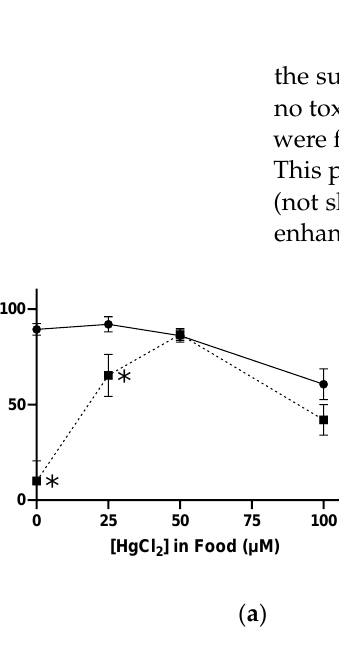
Figure 9. Eclosion and Body Burden Assessment of MeHg and HgCl 2 Mixtures. ( a ) Eclosion: experimental data from Figure 6 represented as ability to complete eclosion at varying levels of HgCl 2 while fixing MeHg food concentration at 0 µM or 10 µM. ( b ) Body Burden Assessment: Internal dose of total Hg of pupae after exposure to MeHg and HgCl 2 mixtures in food alongside what might be expected from adding the body burdens of individuals treated with each metal individually. (* p < 0.05 compared to fixed HgCl 2 dose at 0 µM MeHg, two-way ANOVA).